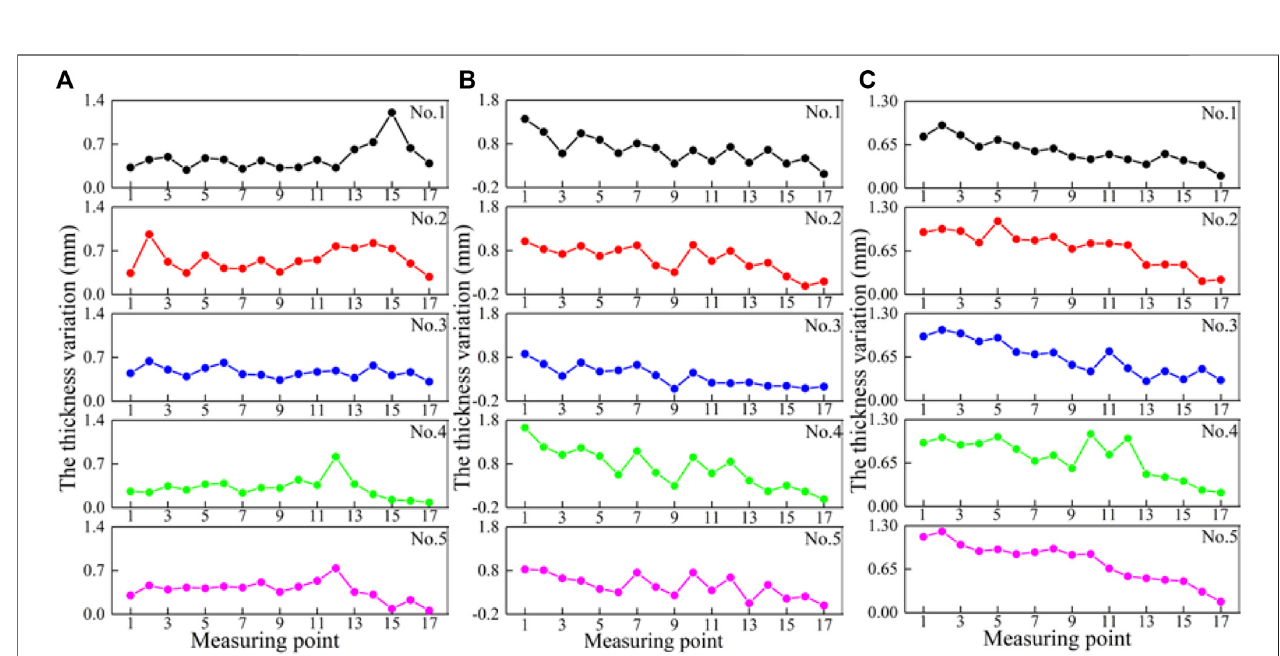
FIGURE 8 | Thickness variation of the blade at measuring points related with different mass concentrations (A) 15% mass concentrations, (B) 20% mass concentrations, and (C) 30% mass concentrations.